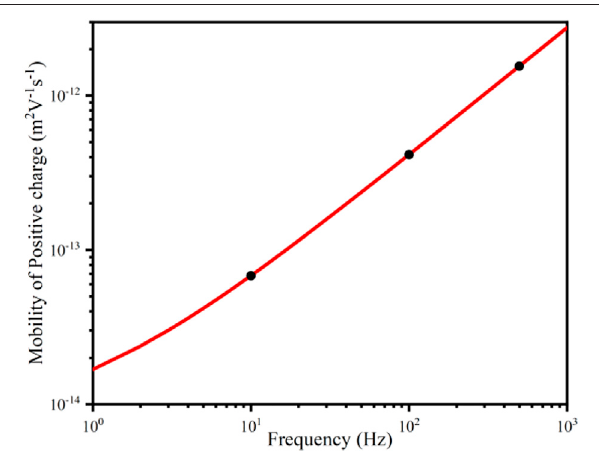
FIGURE 3 | Relationship between the maximum mobility and